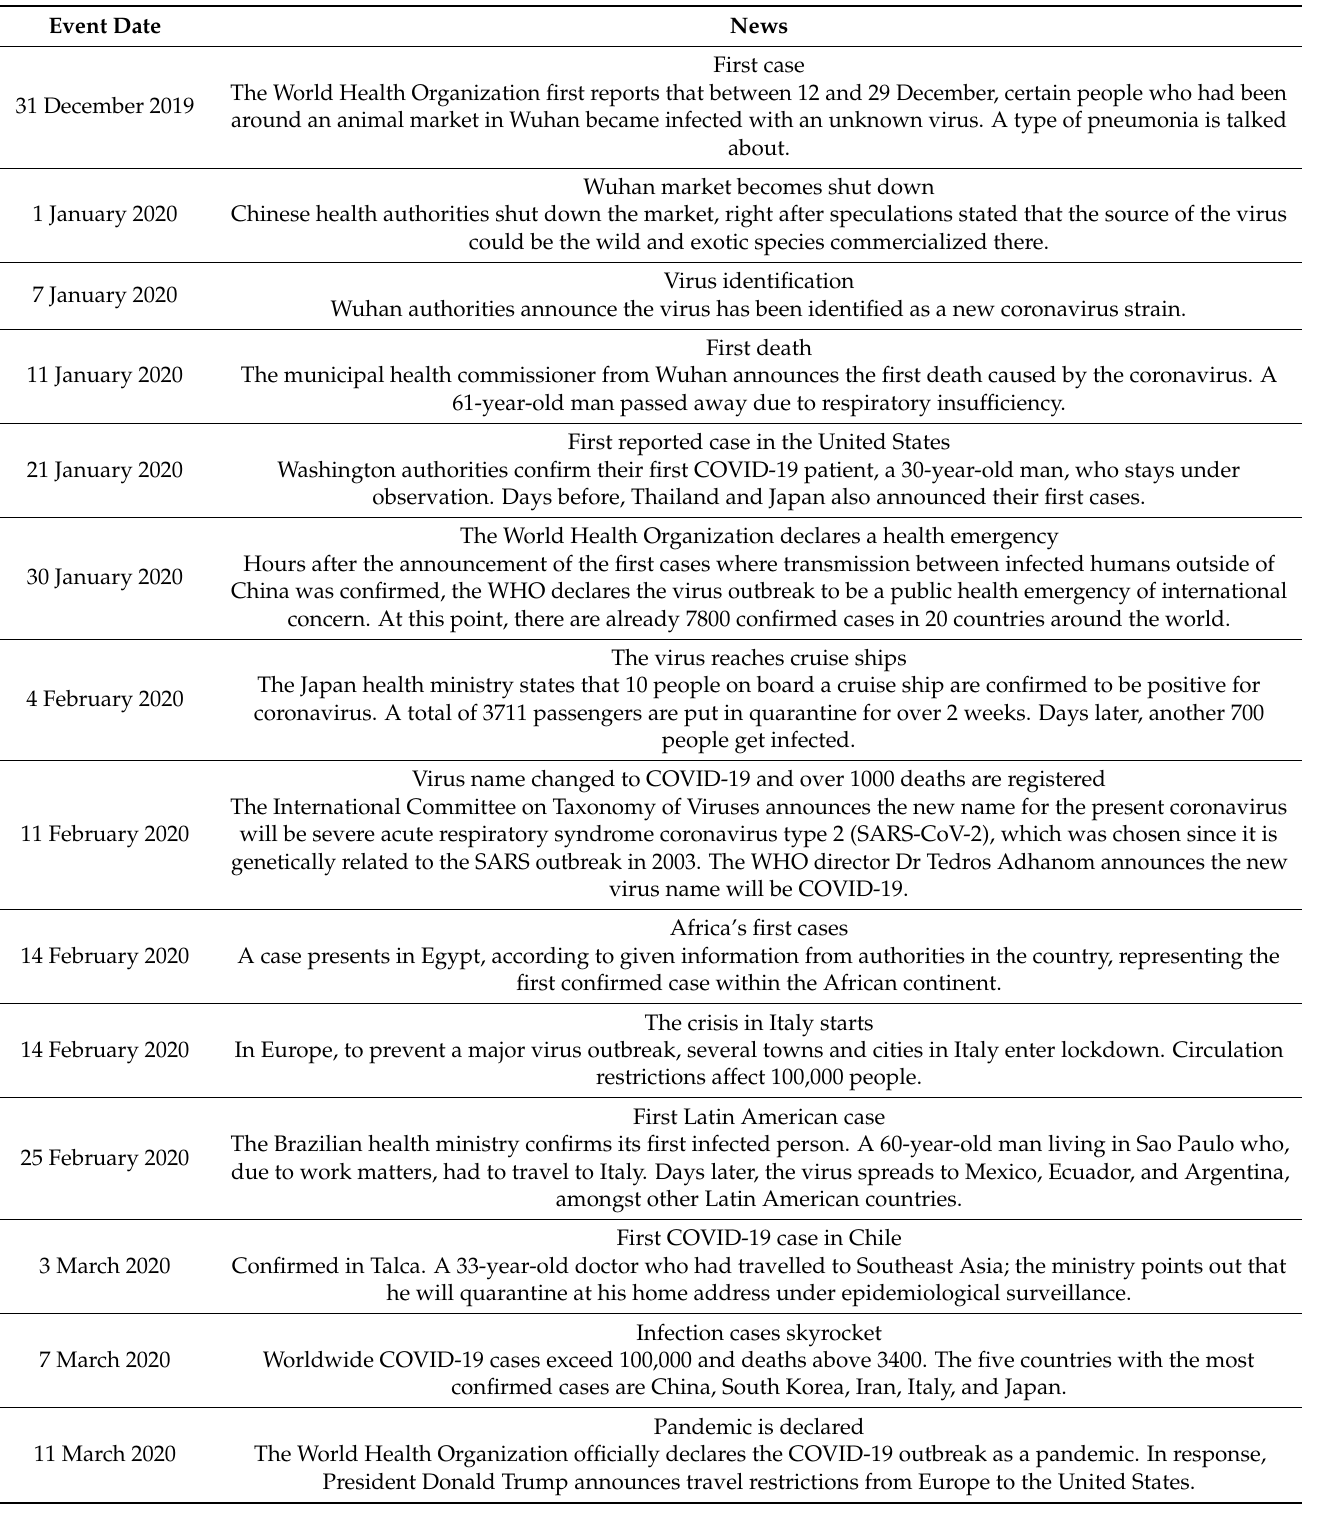
Table 2. COVID-19 pandemic timetable. Source: (CNN Chile